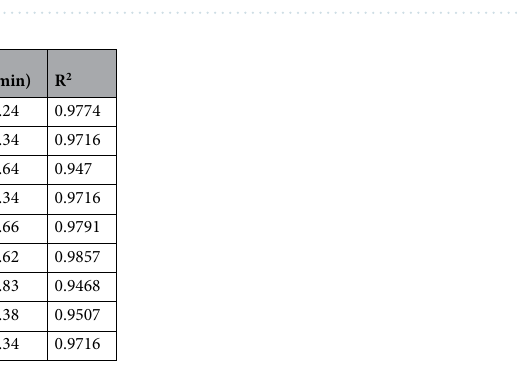
Figure 11. Yoon–Nelson model linear fitting curve for bed heights, flow rates and concentrations. The dots indicate experimental results while the lines show model fit.